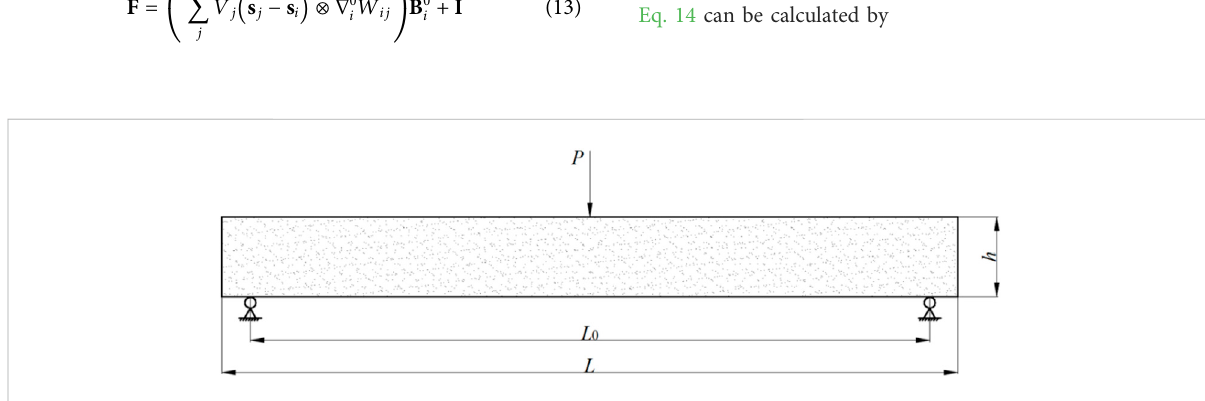
Schematic diagram of three-point bending test of ice beam.